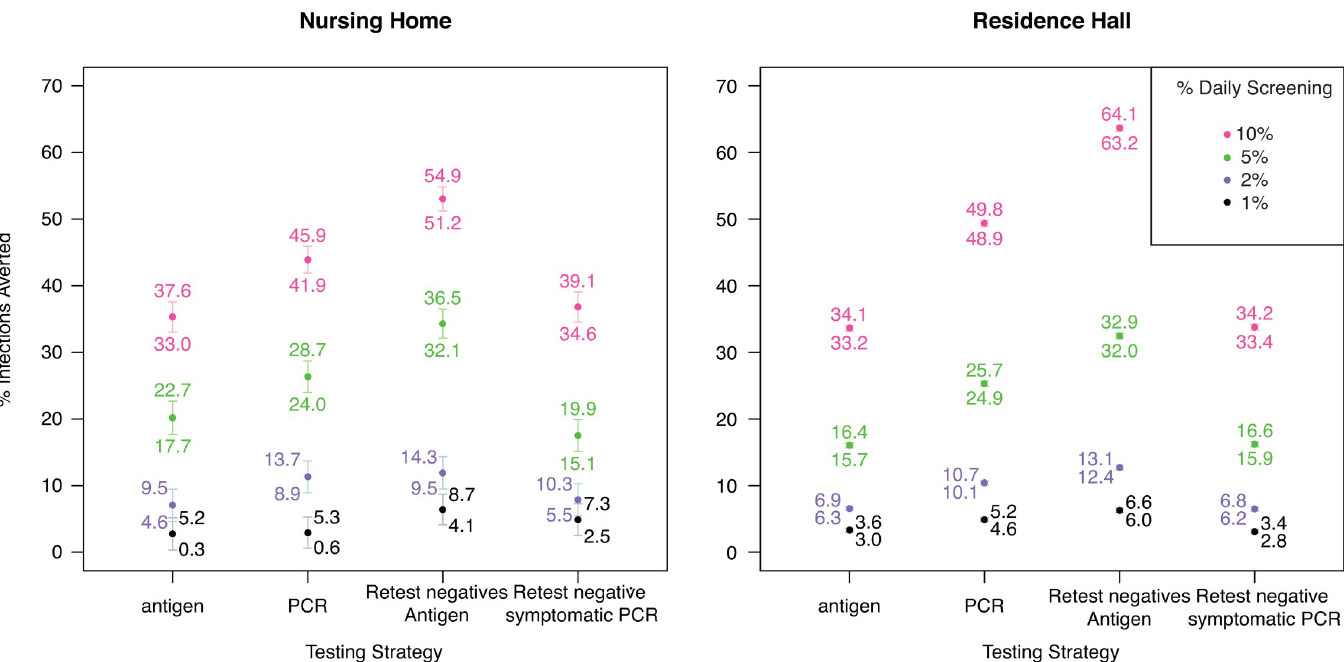
Fig 3. Percent infections averted for different testing strategies at different daily surveillance testing percentages. Red = 10%, green = 5%, blue = 2%, black = 1% daily surveillance testing. Filled circles show means, whiskers show 95% CI. Text labels indicate values of upper and lower 95% confidence interval bounds.